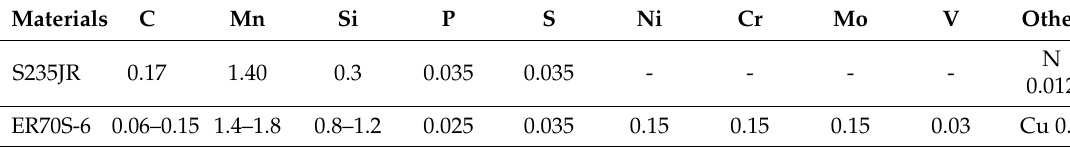
Table 1. Chemical compositions (in wt%) of base metal and filler wire (Fe balance).